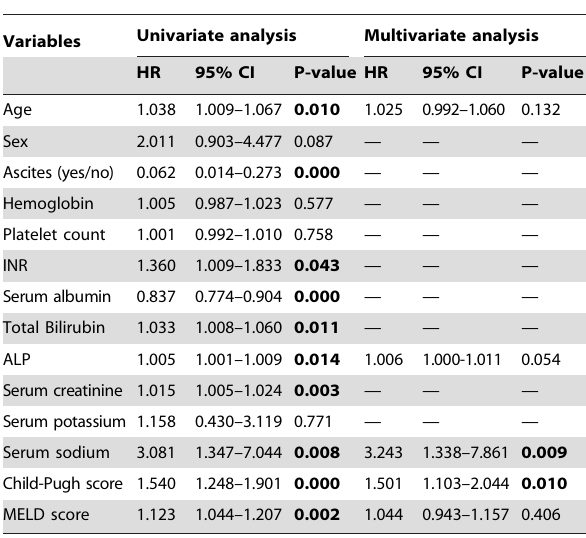
Table 3. Univariate and multivariate analyses of pre-TIPS prognostic factors associated with one-year survival in patients in the training cohort with covered stents.